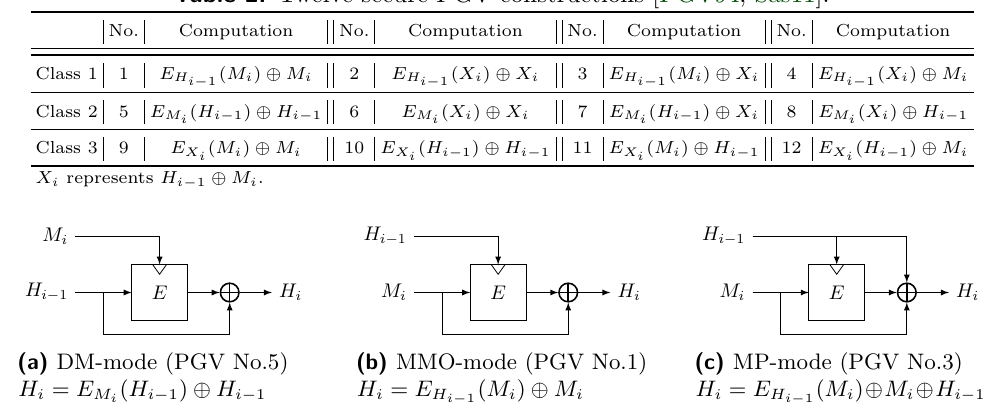
Figure 6: Illustrations for DM, MMO, and MP modes [Sas11,